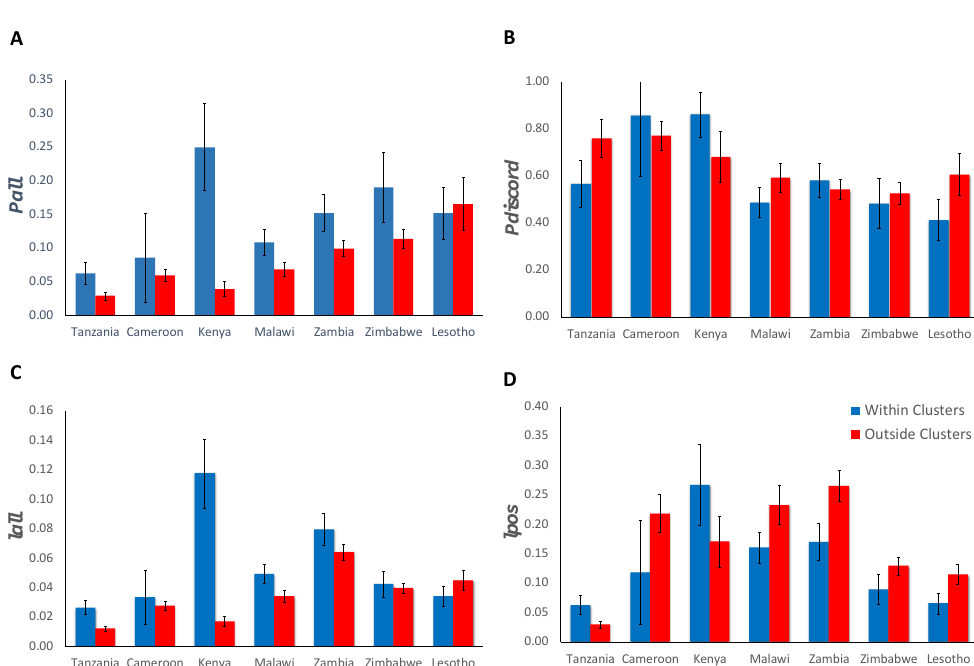
Figure 2. Epidemiological measures of sero-discordancy within and outside of clusters with high HIV prevalence in each of the countries included in the study. ( A ) The proportion of stable discordant partnerships among all stable partnerships ( P all ); ( B ) the proportion of HIV discordant partnerships among all stable partnerships with at least one HIV-infected individual in the partnership ( P discord ); ( C ) the proportion of individuals engaged in stable HIV discordant partnerships ( I all ); ( D ) the proportion of all HIV-infected individuals engaged in stable HIV discordant partnerships ( I pos ). Countries are shown in order of increasing national HIV prevalence.